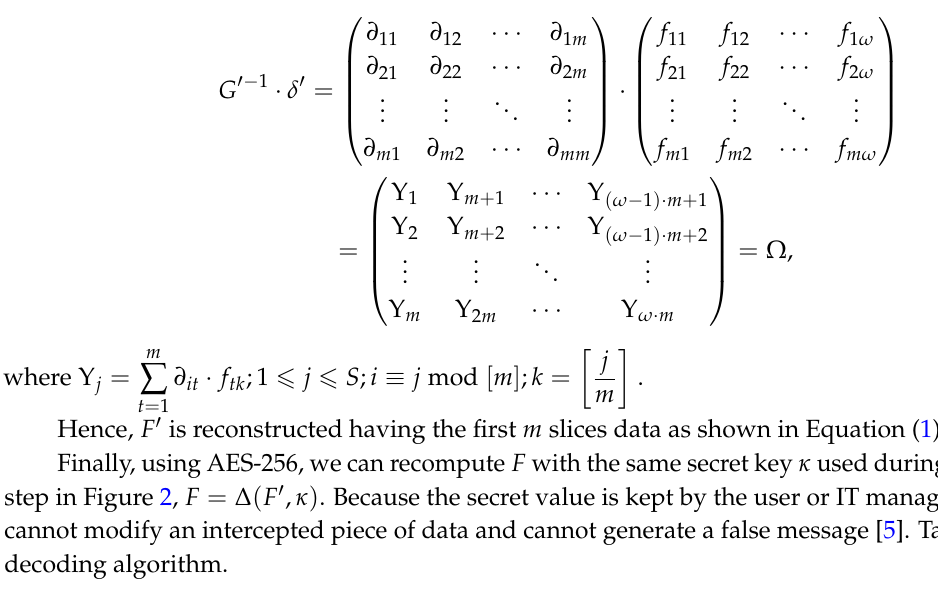
Table 3. Decoding algorithm pseudo